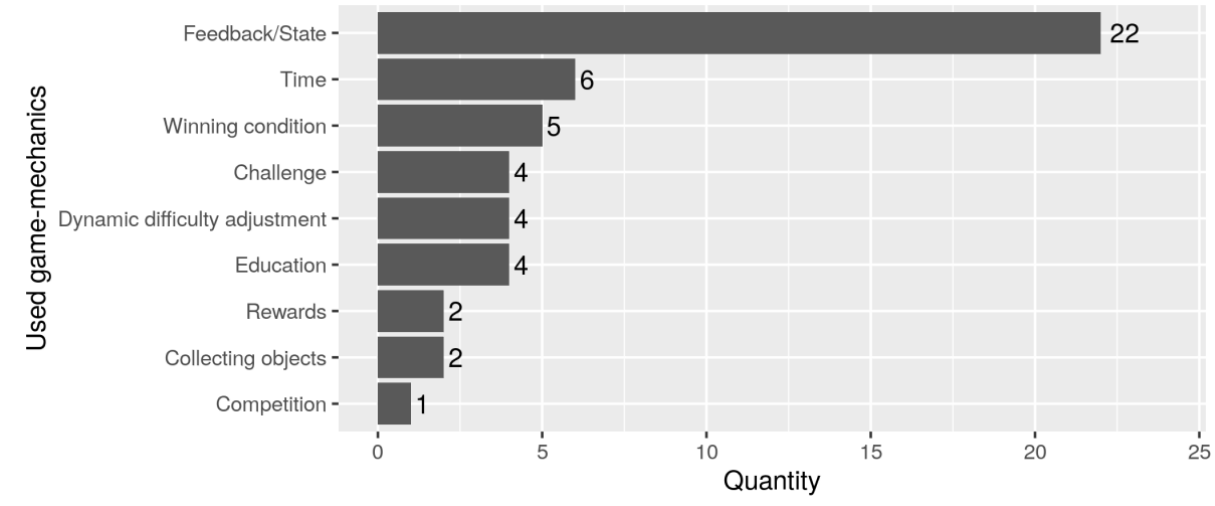
Figure 4. Overview of game mechanics ordered by